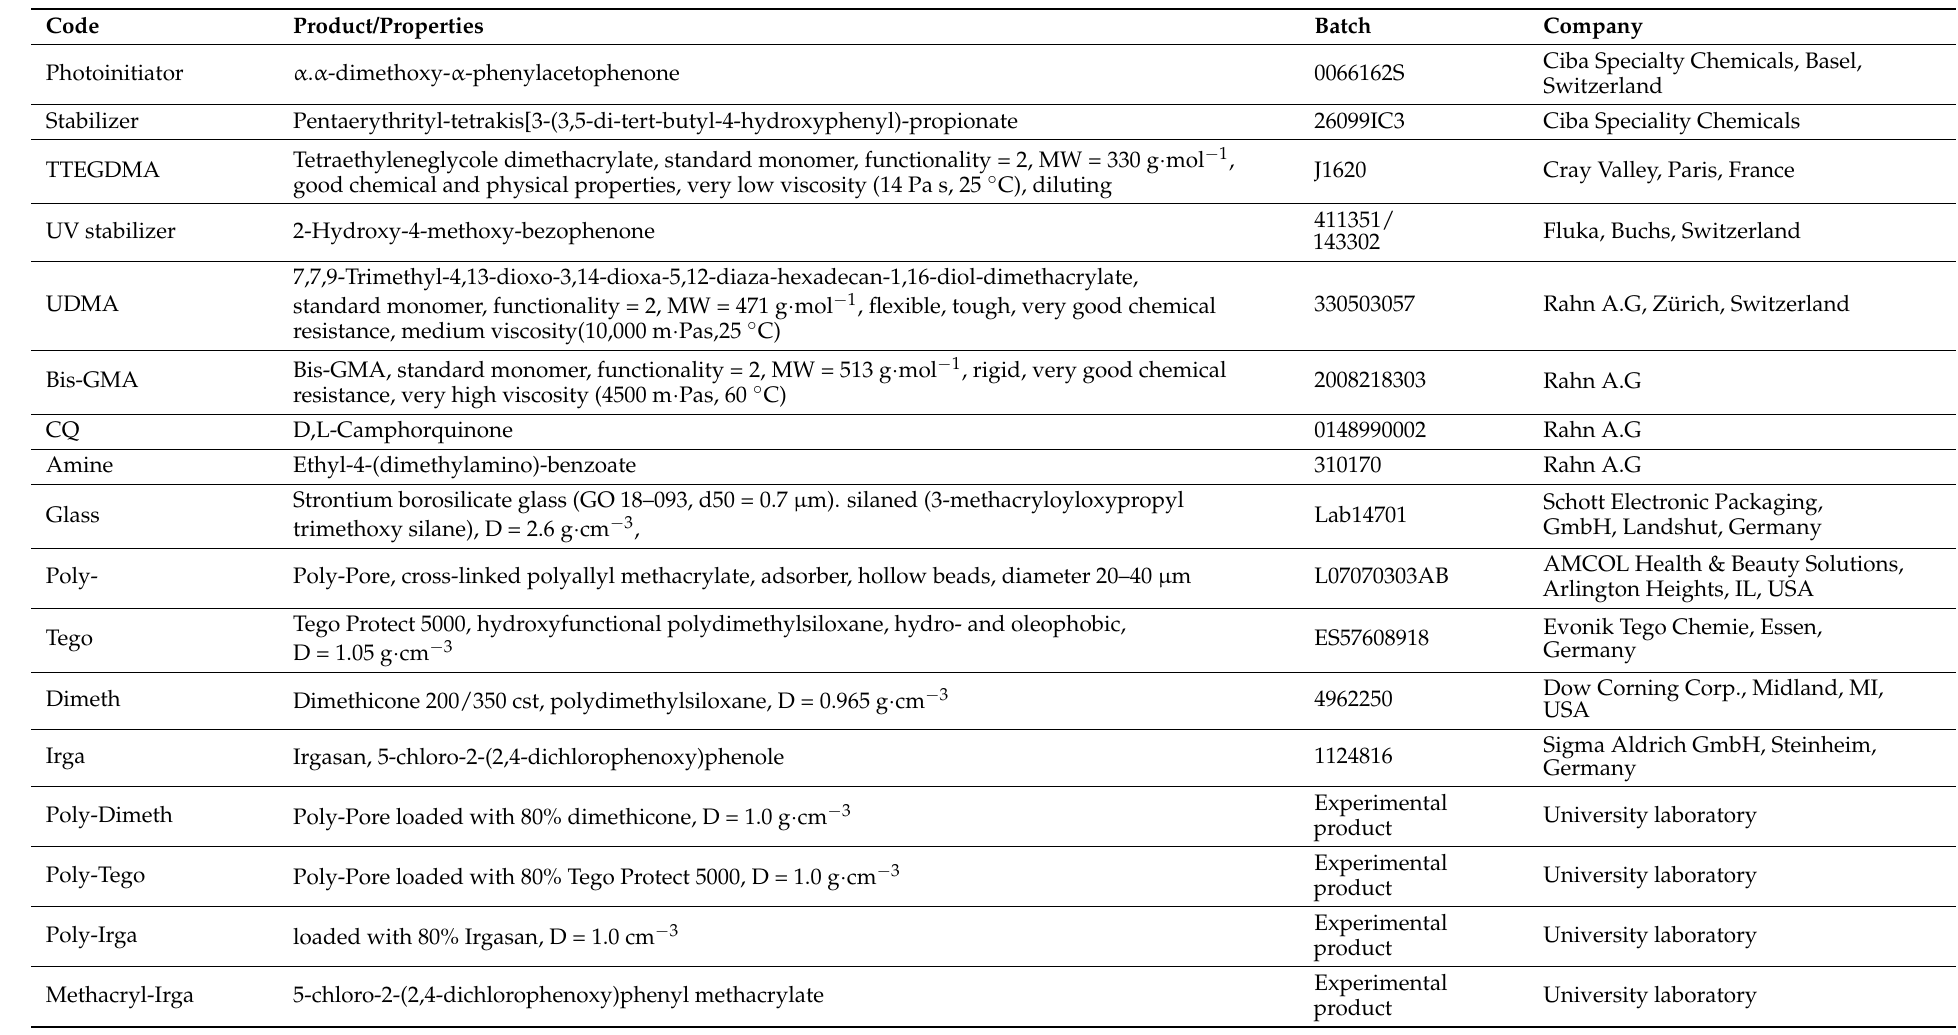
Table 2. The raw materials, based on the manufacturers’ technical data